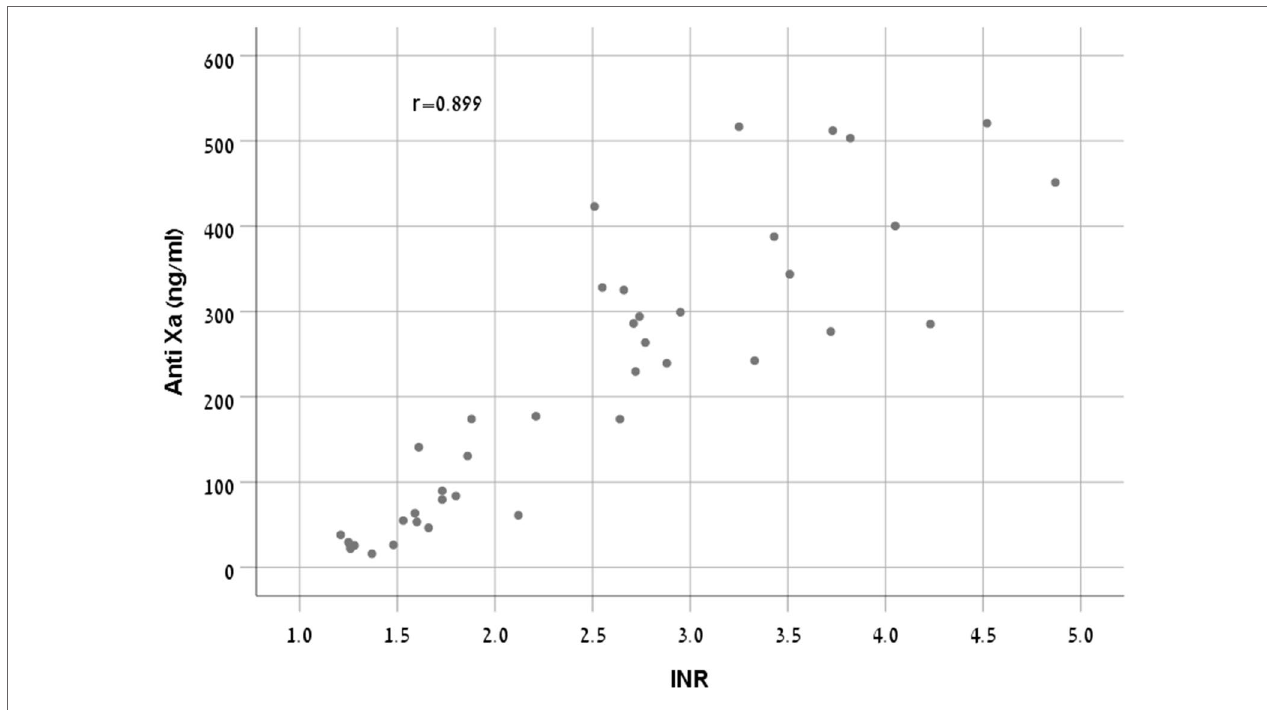
FIGURE 1 | Correlation between INR and Anti-FXa in the rivaroxaban treated group.